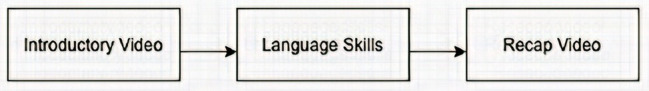
Integration of videos clips in classroom